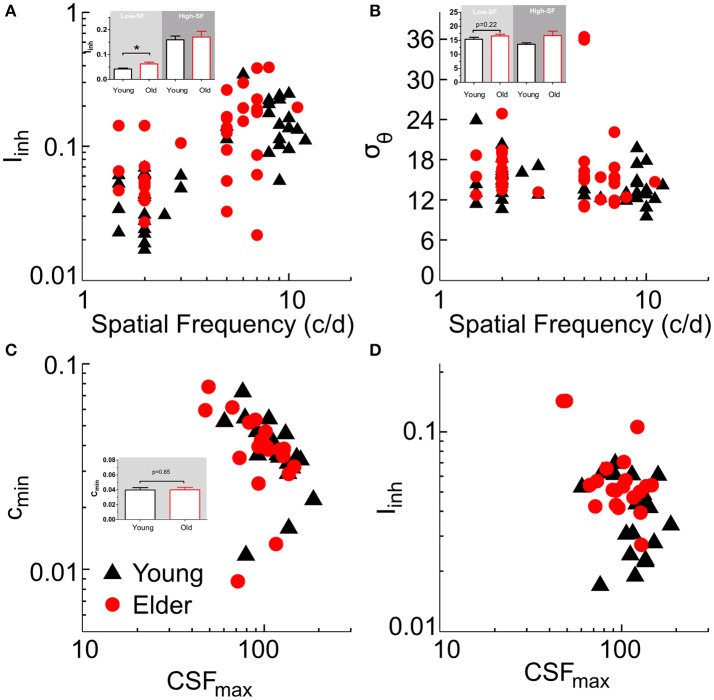
Model fitting results. Summary plots of subjects model parameters (Iinh, σθ, cmin) obtained from tilt repulsion data (A,B) and contrast sensitivity data (C) and relations to the SF (A,B) or peak contrast sensitivity (C,D). Insets depict histograms of the corresponding variable on the ordinate with significance values for the low-SF case.